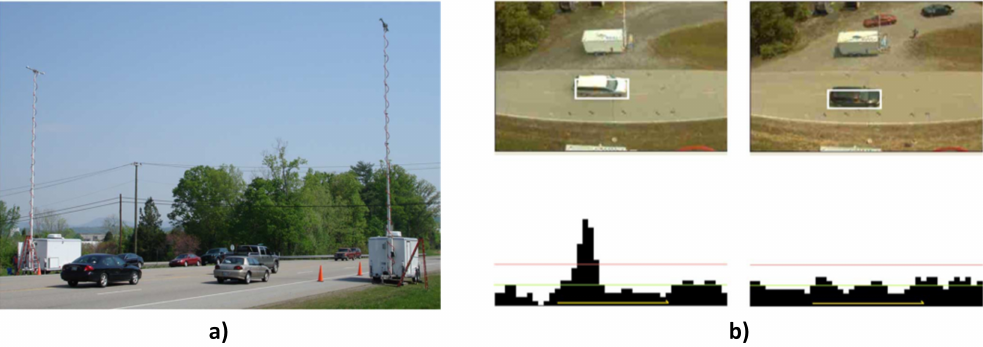
Figure 4. ( a ) Twin trailers. The video cameras were mounted on the top of the poles. ( b ) Top pictures are the images of the vehicle (bounded by white square), and the bottom graphs are the gamma count per pixel for a slice through the gamma image of the vehicle. The left images are for a vehicle with a source, and the right are for a vehicle without a source [26].